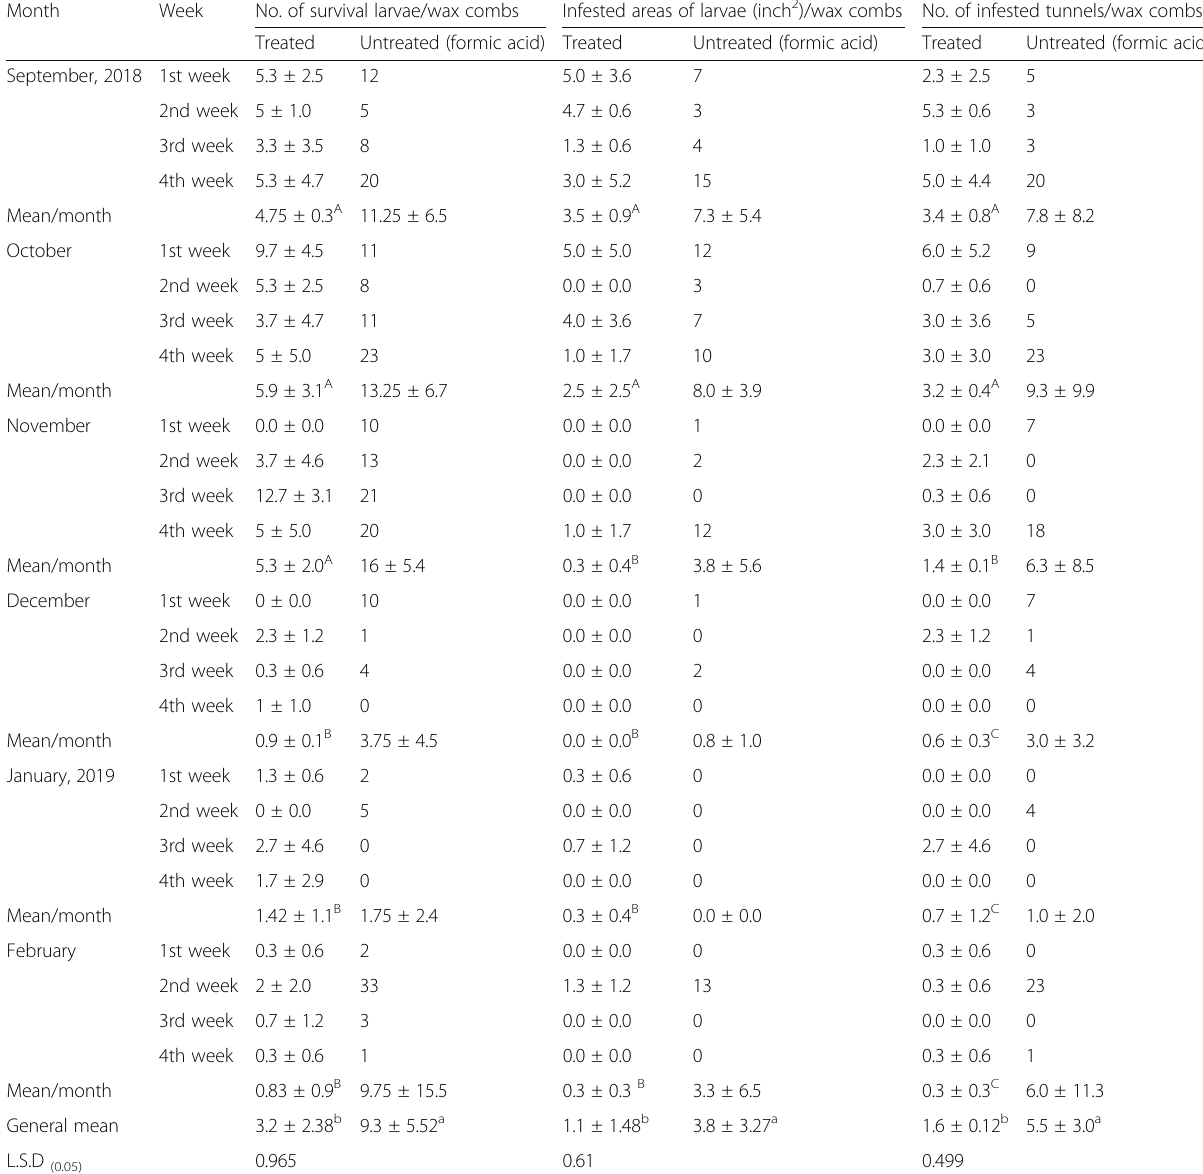
Table 2 Mean numbers of dead larvae, infested areas, and numbers of infested tunnels/colony caused by the greater wax moth, G. mellonella in treated and untreated stored wax combs Month Week No. of survival larvae/wax combs Infested areas of larvae (inch 2 )/wax combs No. of infested tunnels/wax combs Untreated (formic